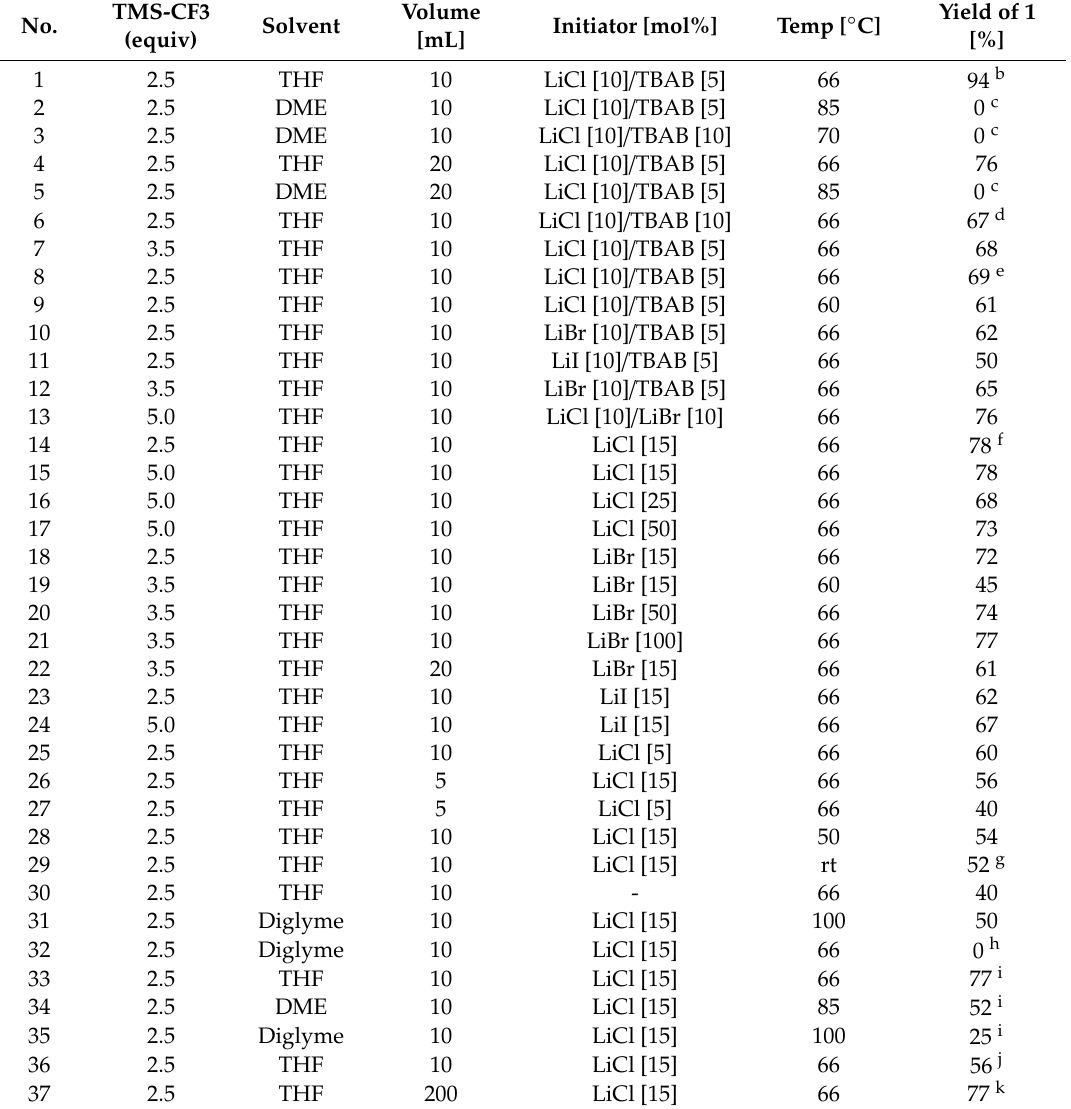
Table 3. Carbene insertion into 11 using TMS-CF 3 as the carbene source a